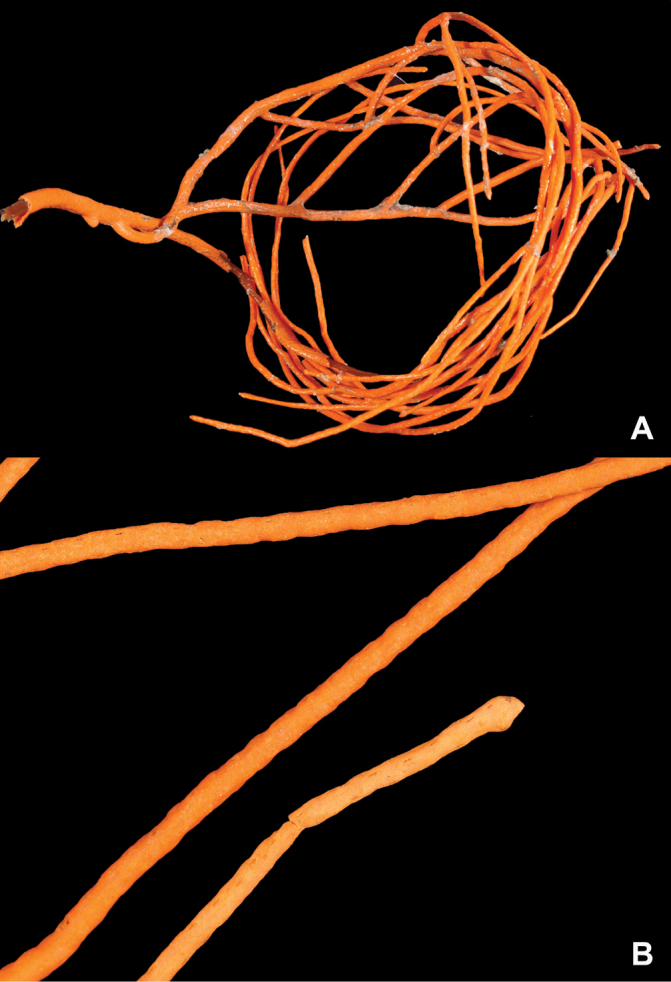
Leptogorgiaflexilis, SBMNH 422941. A shows colony color, and interesting disposition of branches, with tendency to droop. Colony, gently extended, ~30–40 cm tall B Close up of several branches. Note marked point of branch tip on end of lowest branch.